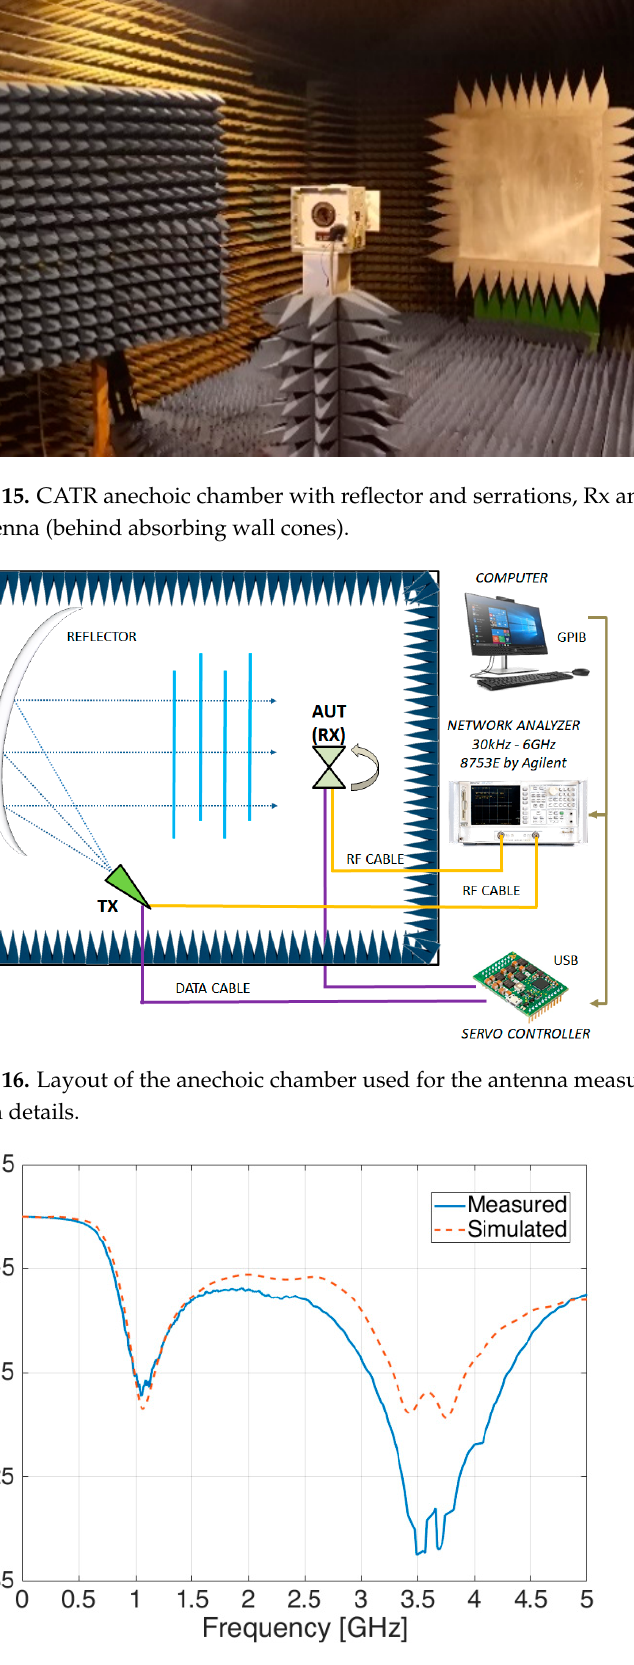
Figure 17. Reflection coefficient S 11 —measured (blue line) and simulated (red dashed line).